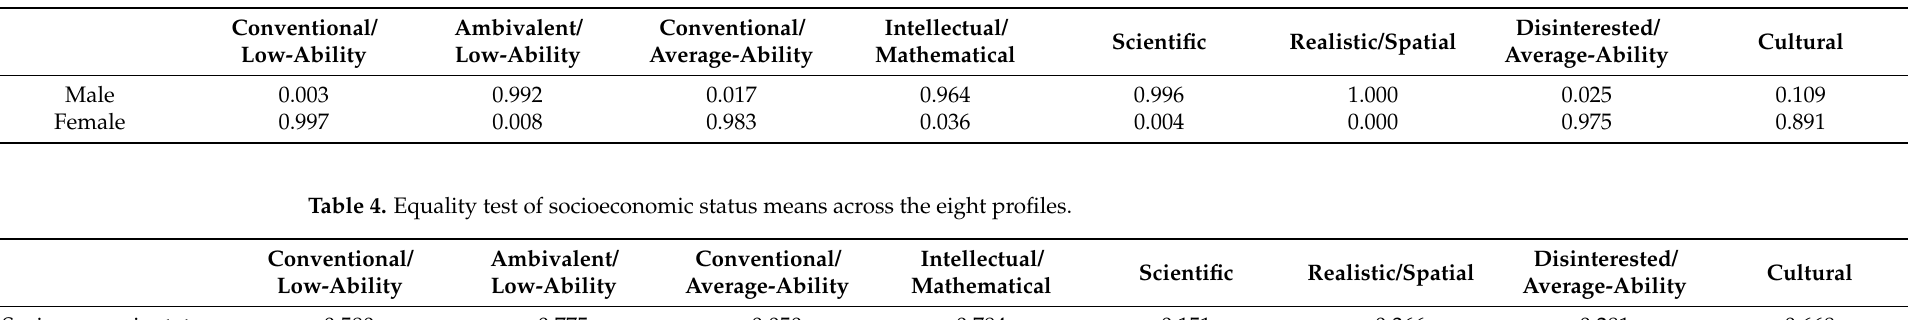
Table 3. Equality test of gender probabilities across the eight profiles.